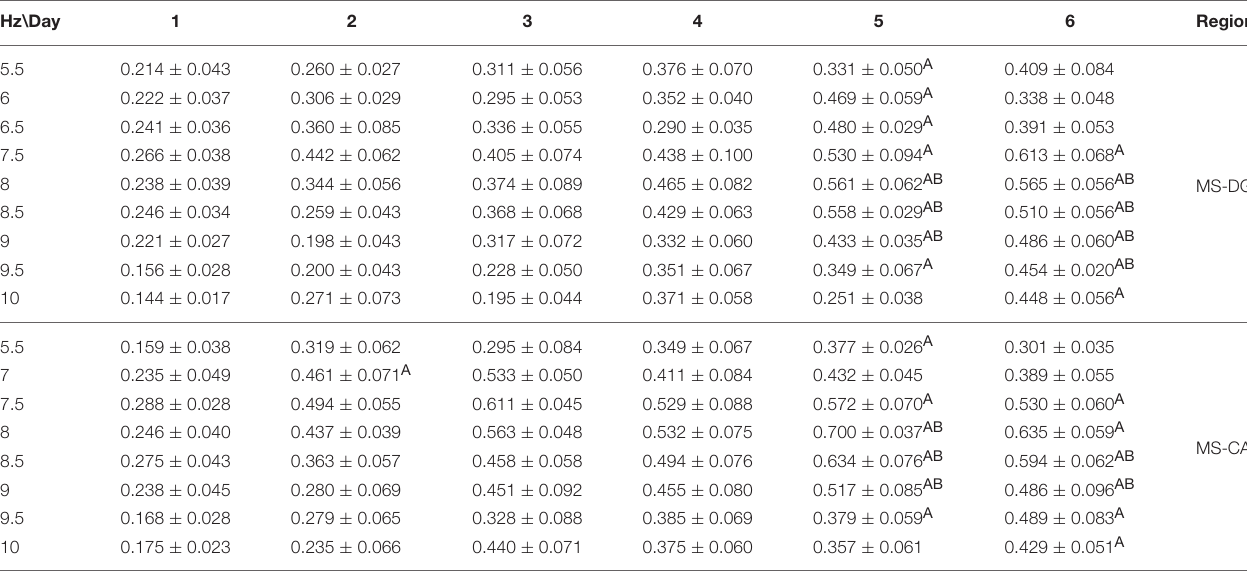
TABLE 3 | Comparison between training days of the coherence between the EEG recorded during the searching for the platform in the Morris water maze task in the CTR group. Hz\Day